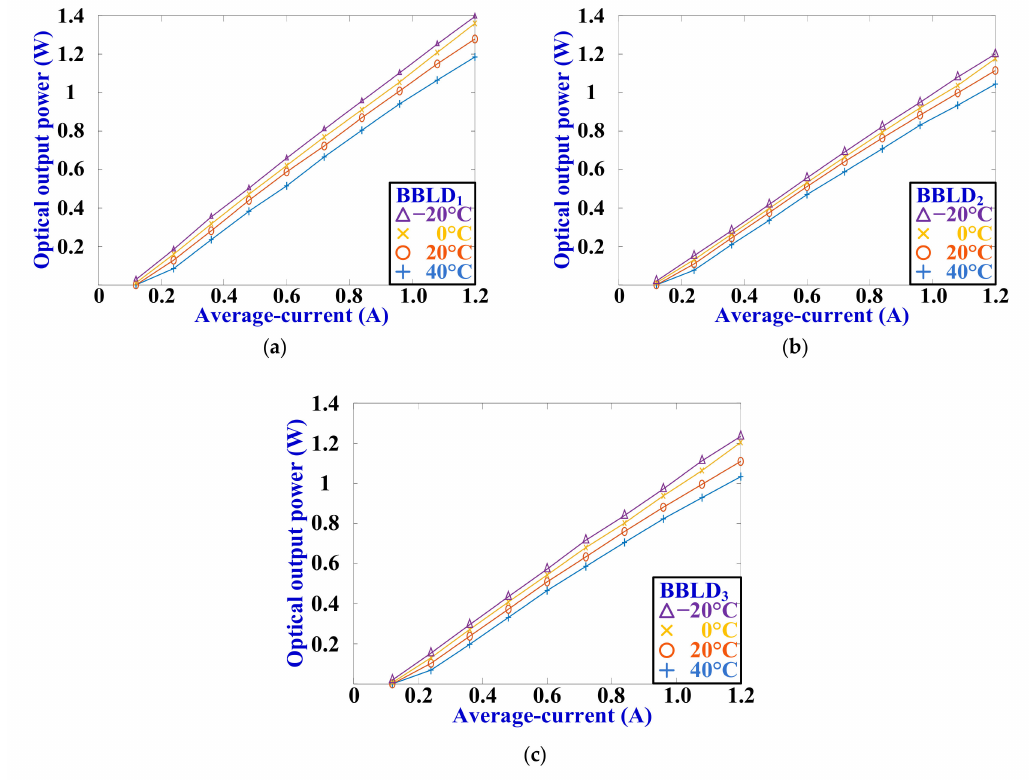
Figure 8. Optical output power (OOP) ( P oop ( avg ) ) variations in average current modulation. ( a ) BBLD 1 . ( b ) BBLD 2 . ( c ) BBLD 3